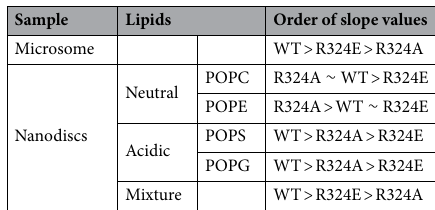
Table 1. Order of slope values in rate vs activity coefficient plots depicted in Fig.